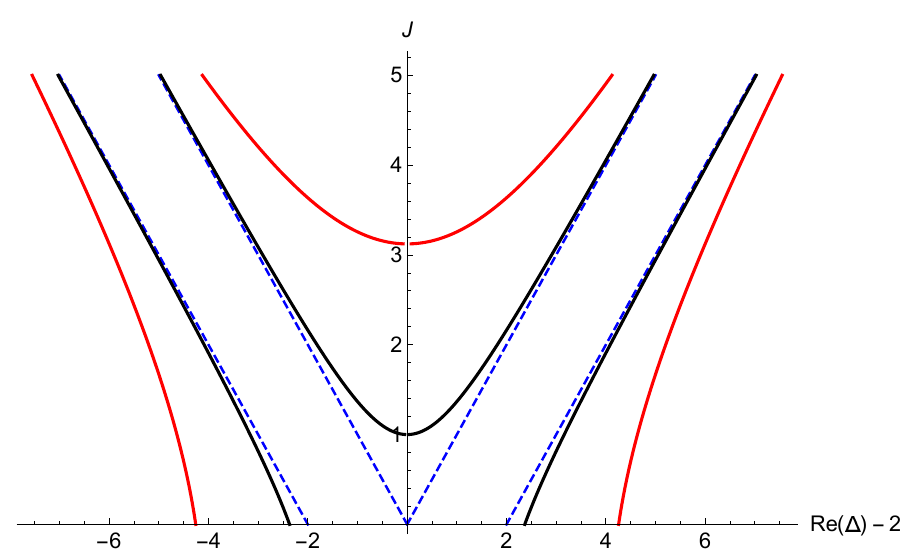
Figure 3 . The Regge trajectories for different values of the coupling: ξ 2 = 0 (dashed lines), ξ 2 = 0 . 75 (black lines) and ξ 2 = 4 (red lines). The scaling dimensions of local operators correspond to nonnegative even J and satisfy Re ∆ ≥